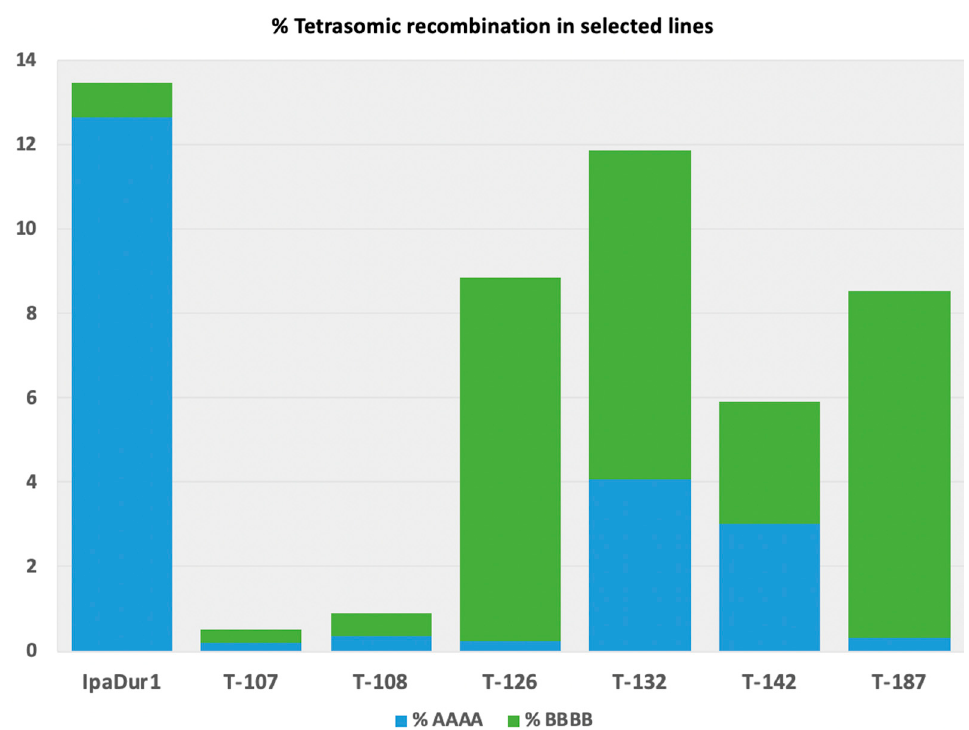
Figure 5. Histograms showing the total percentage of homeologous recombinations in IpaDur1 and six F 2:6 lines. In blue are the conversions from AABB to AAAA, and green, conversions from AABB to BBBB. Note that conversion to AAAA is prevalent in IpaDur1 and conversion to BBBB is prevalent in the segregating